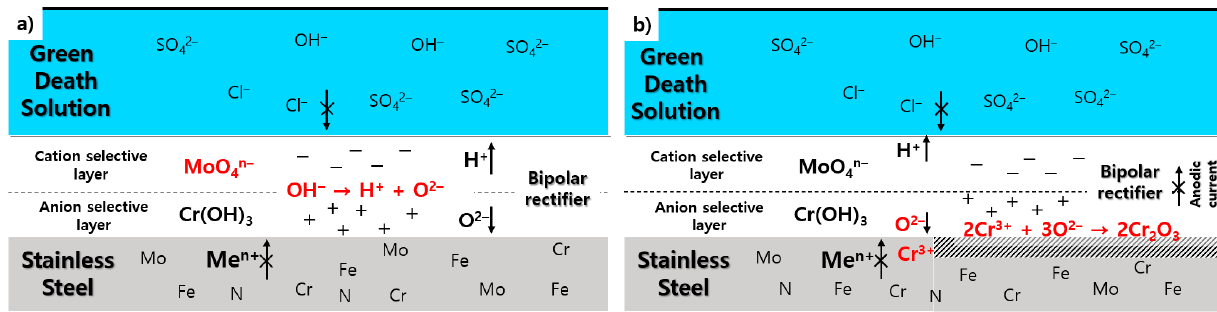
Figure 4. Schematic diagrams of the bipolar model and passive film formation mechanism of stainless steel in a modified green death solution. ( a ) Decomposition of chromium hydroxide and hydroxide ions → formation of oxygen ions and hydrogen ions, ( b ) oxygen ions move to the metal surface → formation of chromium oxide layer.